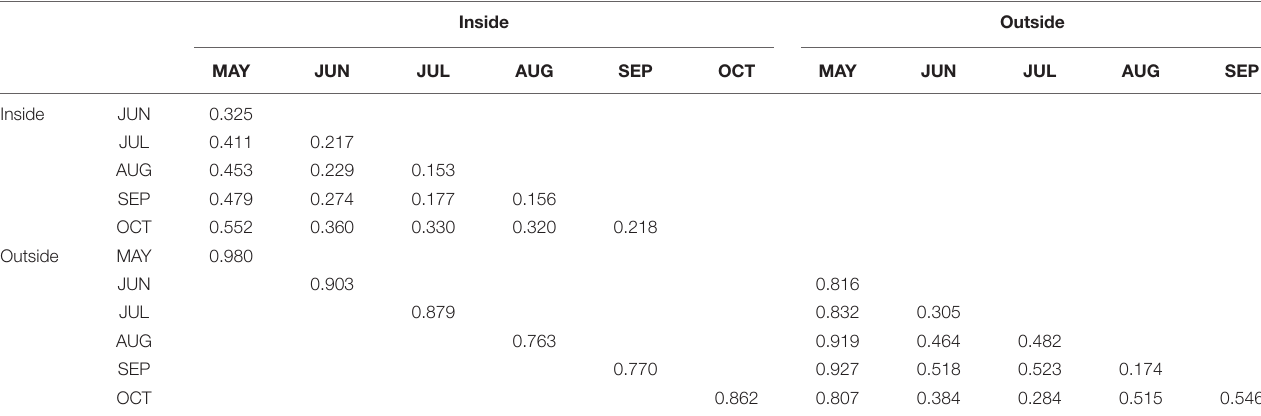
TABLE 1 | Pairwise values of Bray-Curtis dissimilarity indices.